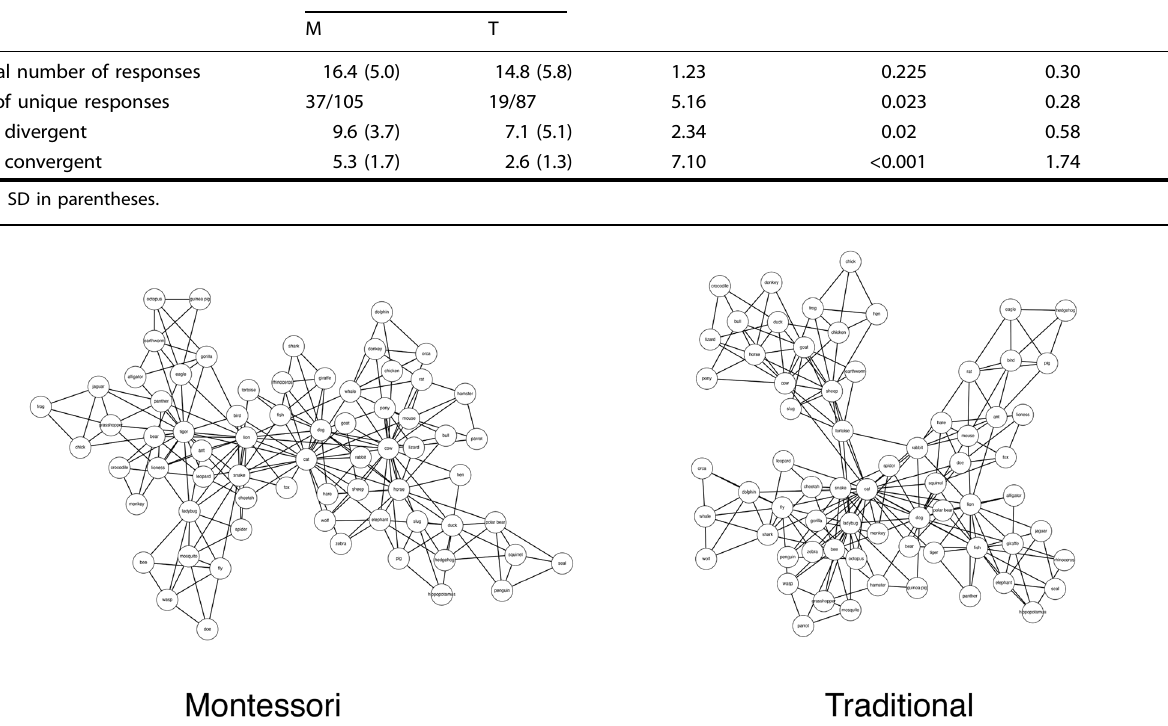
Table 2. Verbal fl uency and creativity data for the Montessori — (M) and traditionally — (T) schooled children. Group